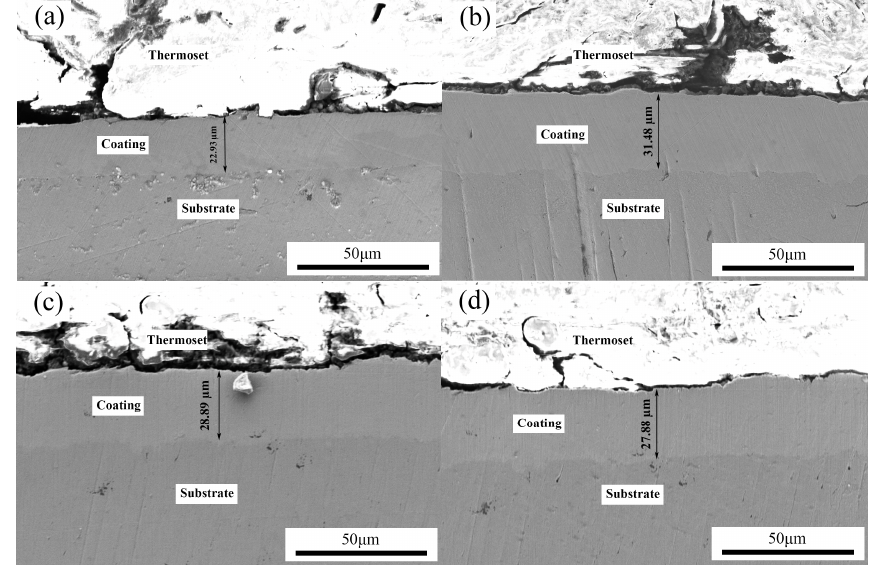
Figure 5. Cross-section images of the Ni–Co–BN (h) nanocomposite coatings with duty cycle of 0.7 and varying pulse frequencies: ( a ) 2 kHz, ( b ) 6 kHz, ( c ) 8 kHz, ( d ) 10 kHz.